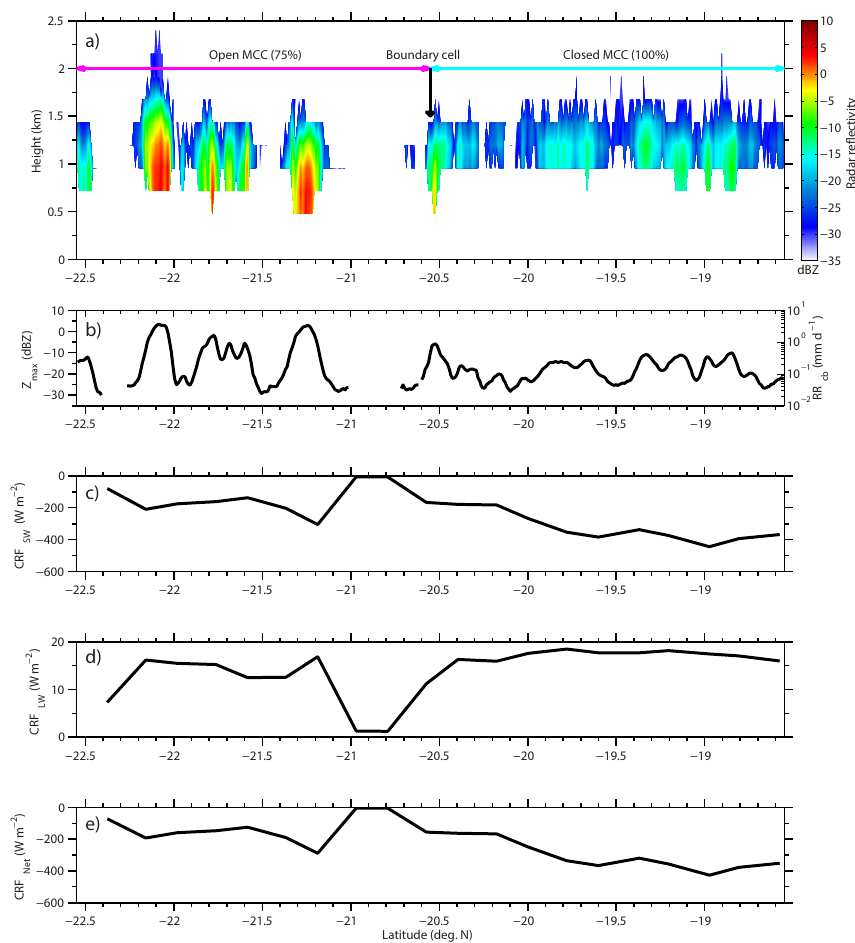
Figure 8. Vertical profiles of CloudSat CPR reflectivity for a selected region showing a transition from closed to open MCC (a) , column maximum radar reflectivity Z max and associated rain rates RR cb at cloud base (b) , CERES shortwave cloud radiative forcing (CRF) (c) , longwave CRF (d) and net (shortwave and longwave) CRF (e)